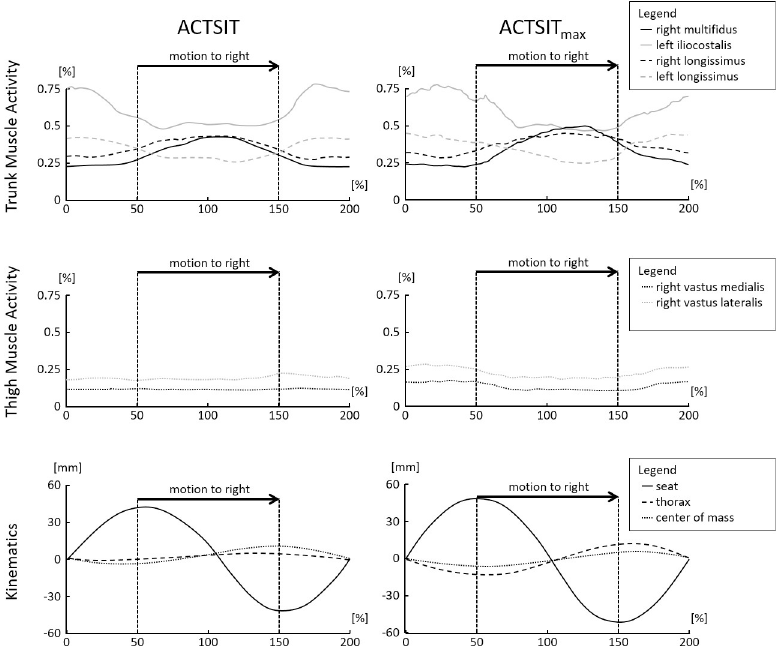
Fig 3. Temporal activity and motion pattern. Time normalized muscular activity and kinematic motion pattern during spontaneous (ACTSIT) and maximum active sitting (ACTSIT max ) over all subjects. The seat is at 0%, 100% and 200% in the central position and at approximately 50% (left) and 150% (right) in the extremal positions. The muscle activity is given as a percentage of the peak activity in walking, kinematics in millimetres (mm).